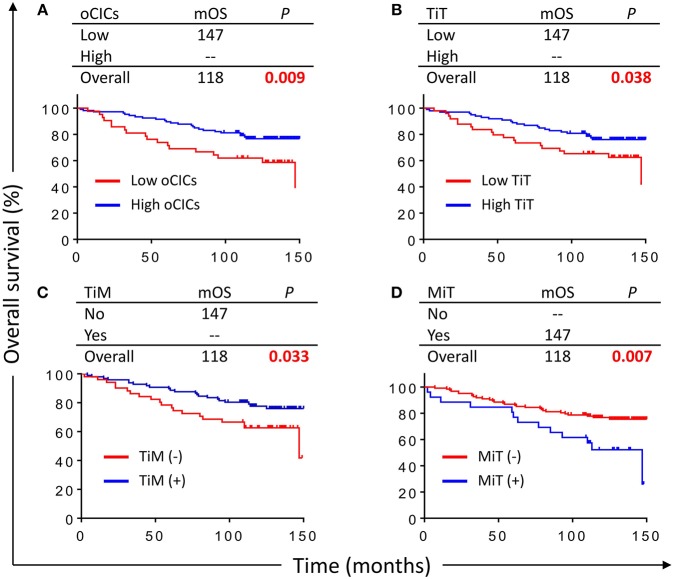
Cell-in-cell structures associate with overall survival (OS) of breast cancer patients. Kaplan–Meier plotting for OS curves of oCICs (A), TiT (B), TiM (C), and MiT (D). High for CICs ≥ 15/core, low for CICs < 15/core; (–) and (+) for cores negative or positive for CICs, respectively.